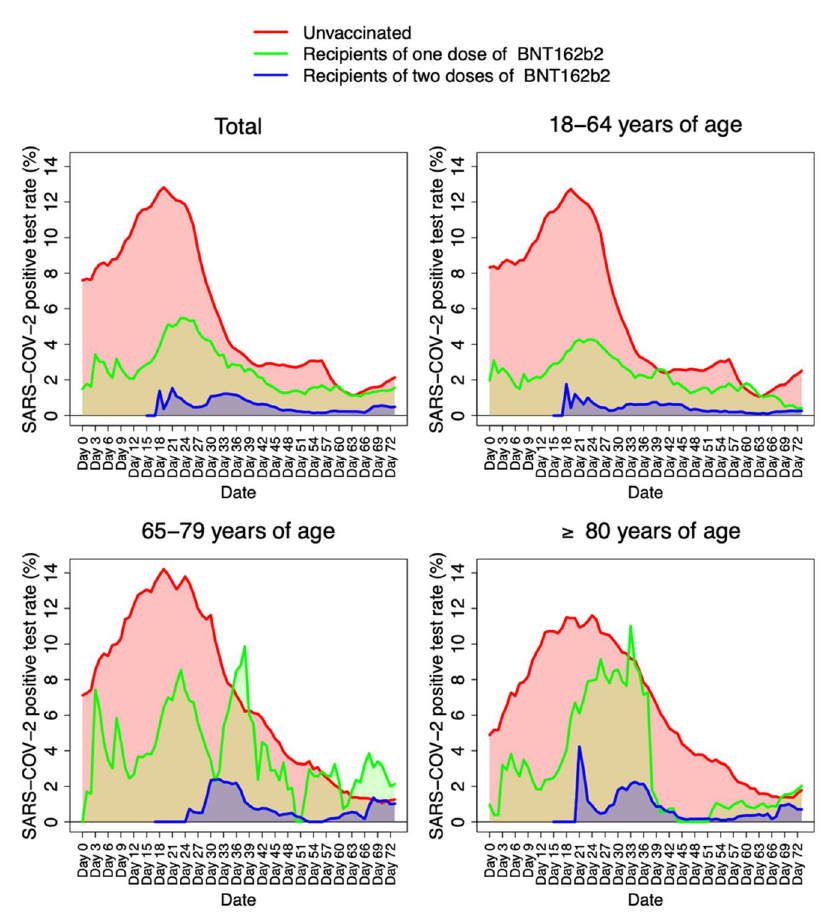
Figure 2. Frequency of weekly positive SARS-CoV-2 tests computed by age groups, and number of administered BNT162b2 vaccine doses. The red line represents the unvaccinated population. The green line represents those individuals who received one dose of BNT162b2. The blue line represents those individuals who received two doses of BNT162b2.